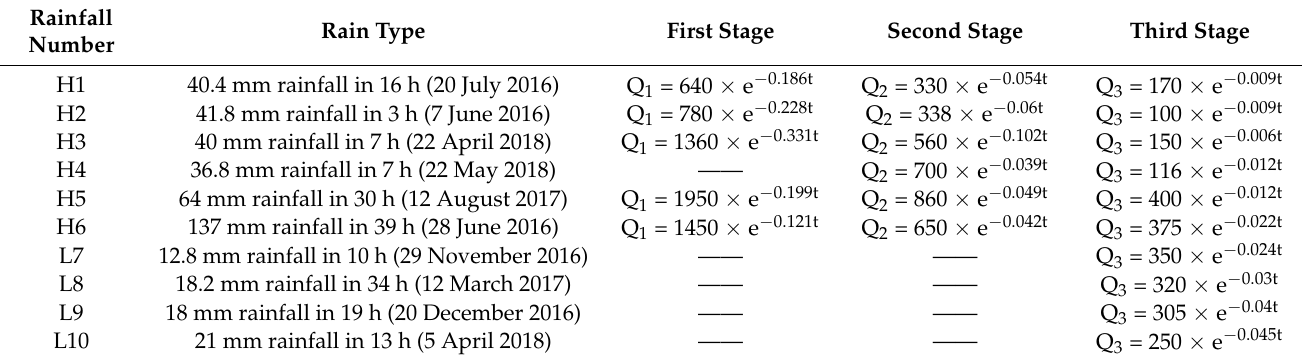
Table 4. Recession coefficients under different rainfall